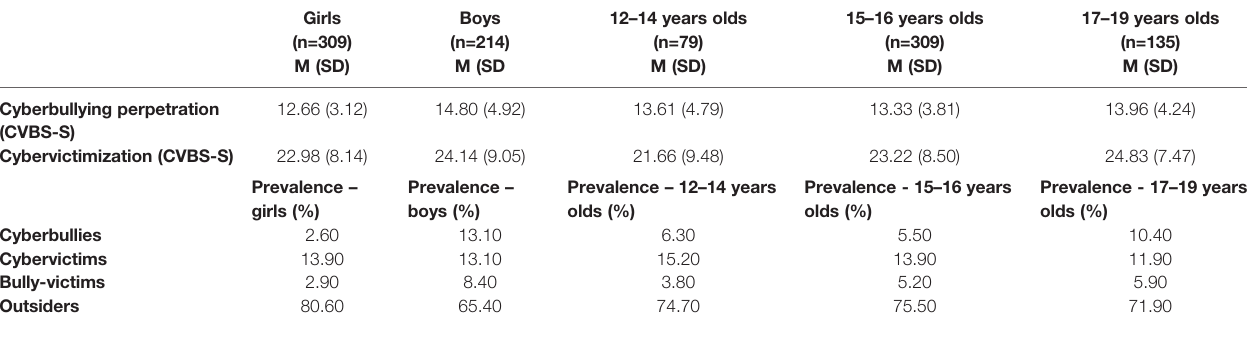
TABLE 2 | Descriptive data about the prevalence of cyberbullying and cybervictimization in gender and age groups. Girls